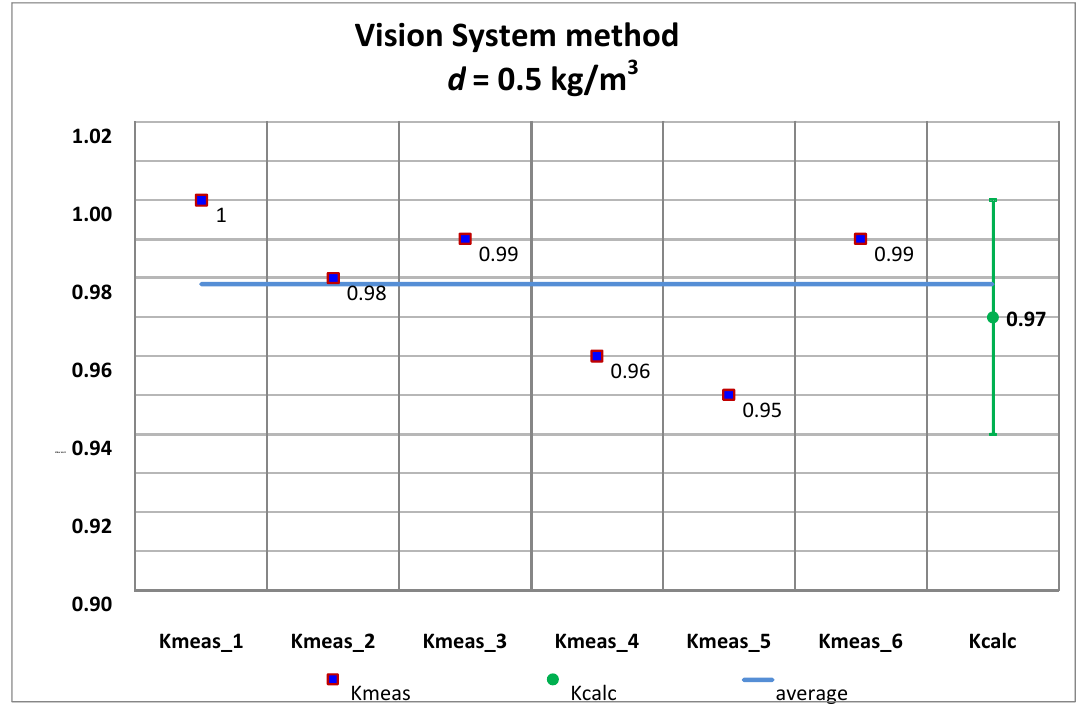
values. Medium accuracy hydrometer. Vision system Figure 23. K meas